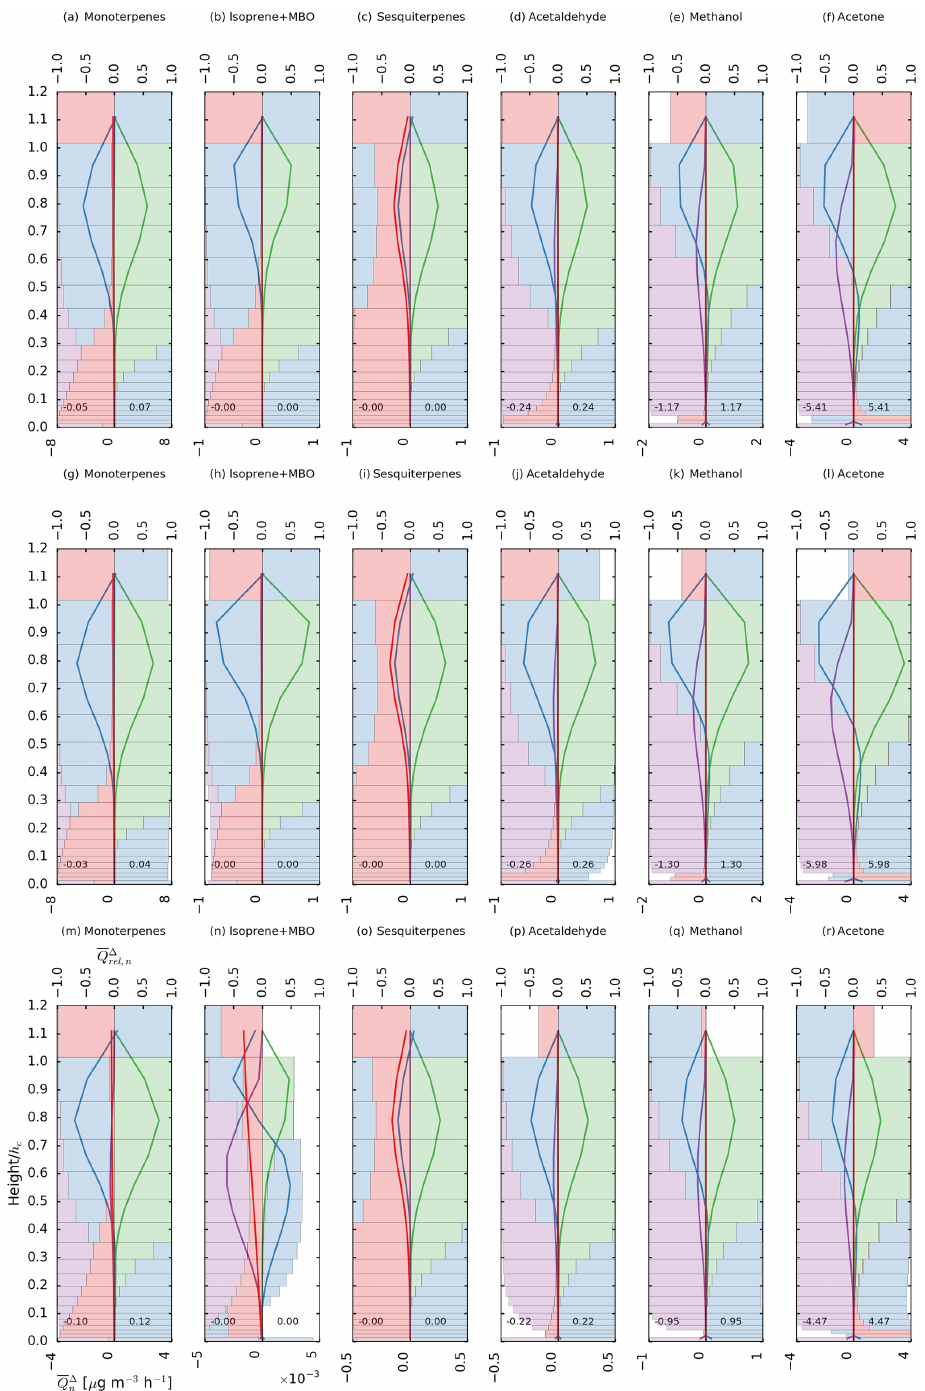
(cid:49) (cid:49) Figure 8. Modelled monthly-averaged vertical profiles of weighted Q n (solid lines) and the relative contributions Q rel ,n (bars) of gas emissions (green), net chemical production and loss (red), turbulent transport (blue), and gas dry deposition (purple) within the canopy for (a) monoterpenes, (b) isoprene + MBO, (c) acetaldehyde, (d) sesquiterpenes, (e) methanol, and (f) acetone. Panels (g) to (l) and panels (m) to (r) are for the same compounds but the average is performed for daytime and nighttime, respectively. The height is normalized by the (cid:49) canopy height ( h c ). The values of weighted Q n at the surface layer are divided by 10 for clarity. The original values at the surface layer for deposition (left) and transport (right) are shown as float numbers at the bottom for each plot. The x labels and y labels of (m) also apply to all the other